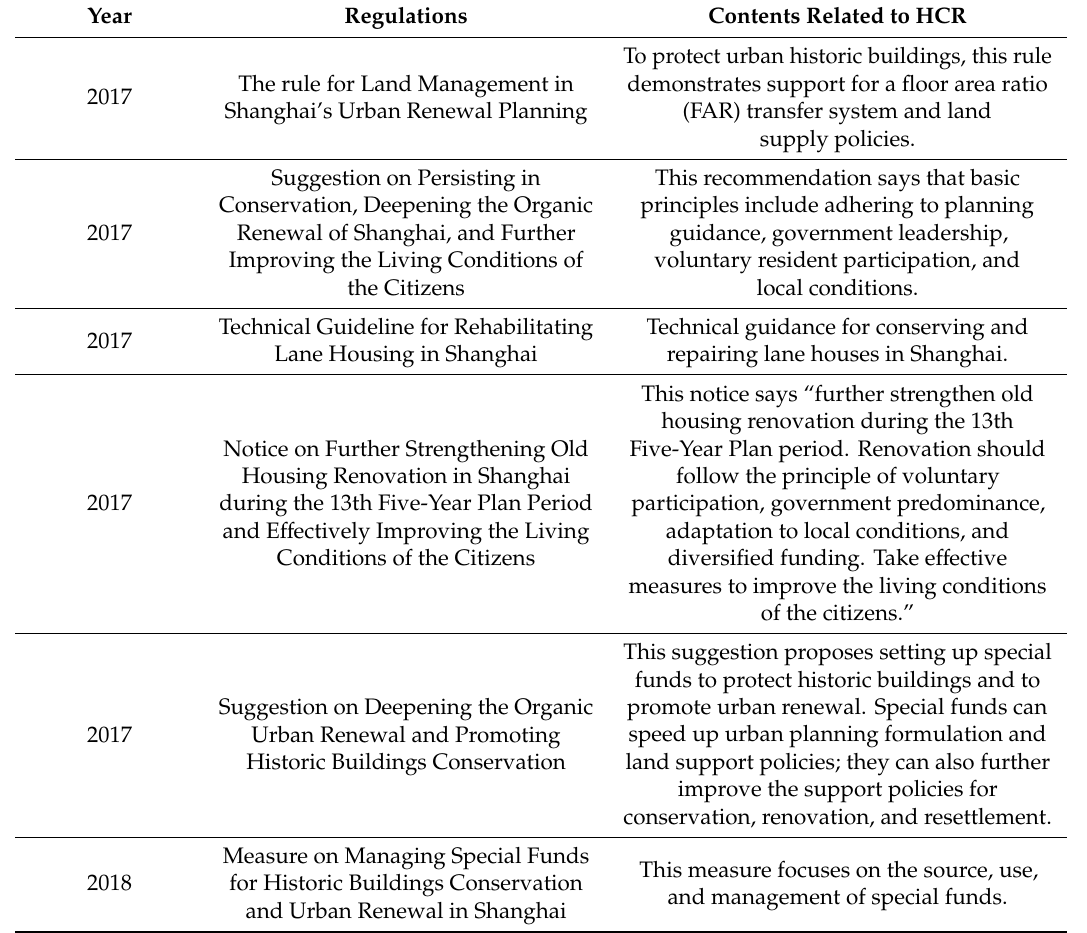
Table 4. Summary of HCR management regulations in Shanghai.